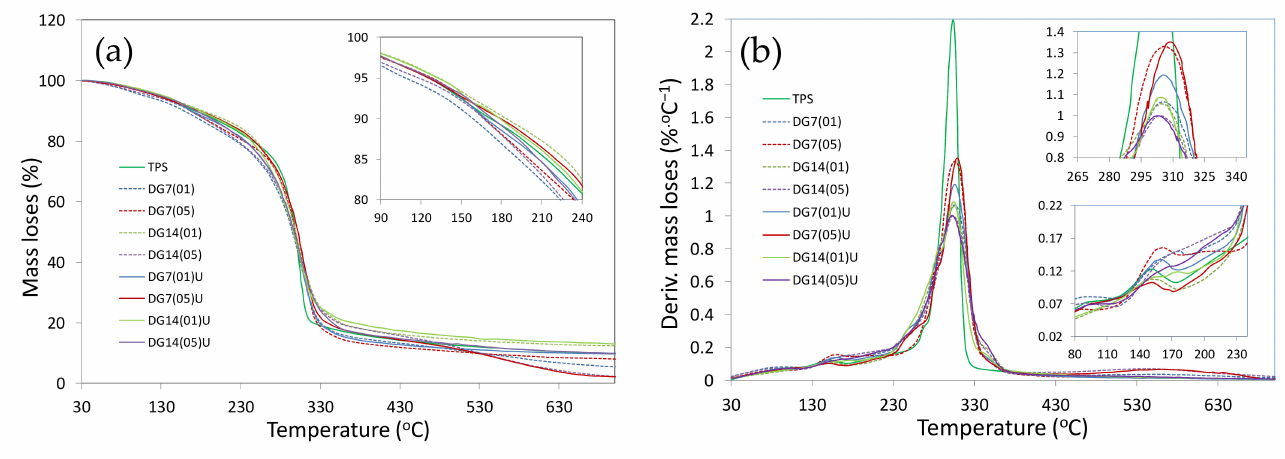
Figure 6. Thermogravimetric analysis of TPS biocomposites: ( a ) mass loses, ( b ) derivative mass change biocomposites